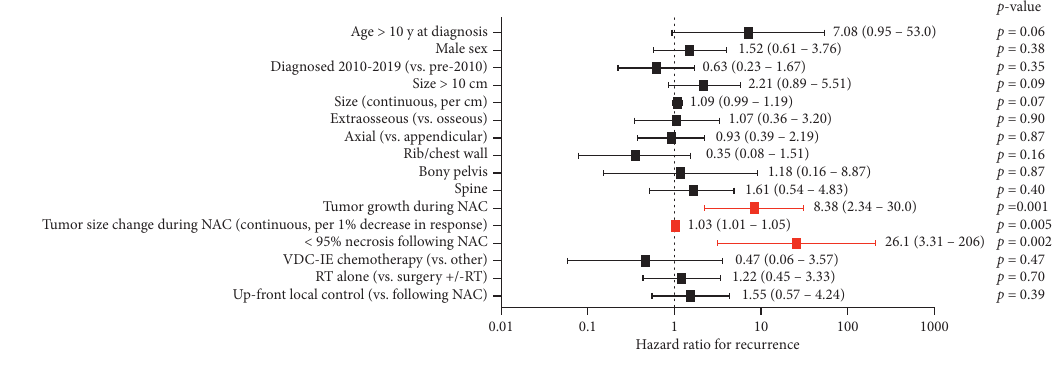
Figure 3: Forest plot of putative risk factors for recurrence of localized Ewing sarcoma. Odds ratios for recurrence with 95% confidence intervals are shown and were obtained by univariable Cox regression modeling. NAC: neoadjuvant chemotherapy; VDC-IE: vincristine, doxorubicin, cyclophosphamide, ifosfamide, etoposide; RT: